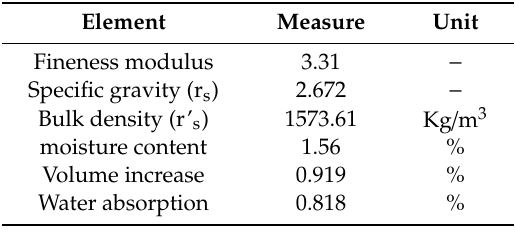
Table 3. Physical properties of used sand.